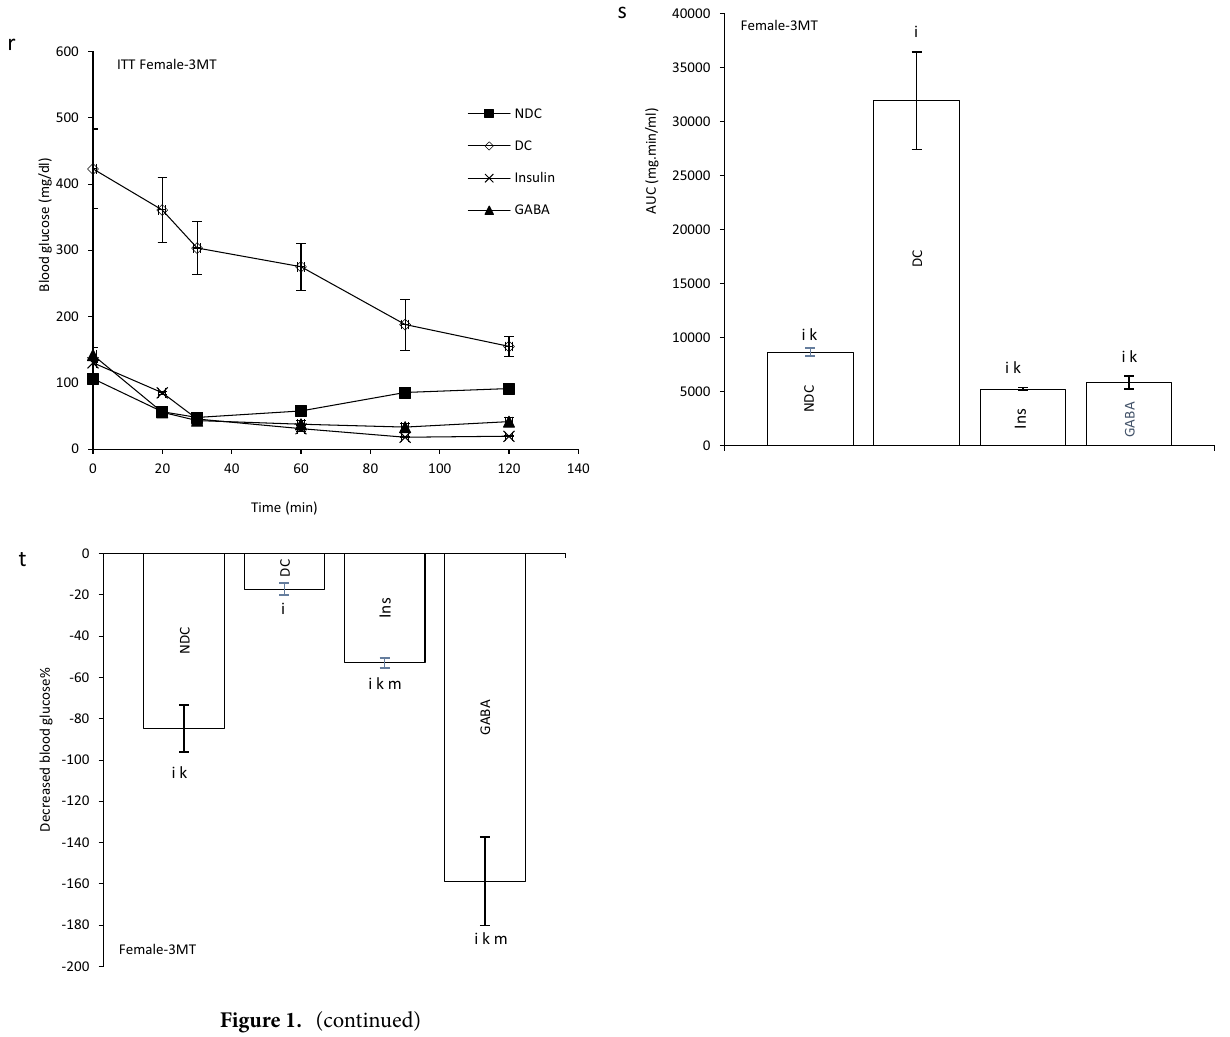
Offspring’s HbA1c level.